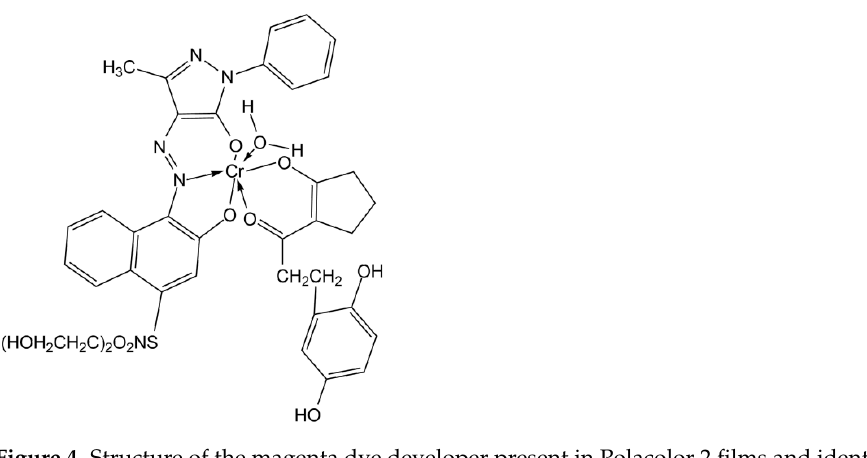
Figure 3. The general structure for a Chromium complexed magenta dye developer in Polaroid films; the X, Y, and Z substituents could vary in different dyes of the same typology.